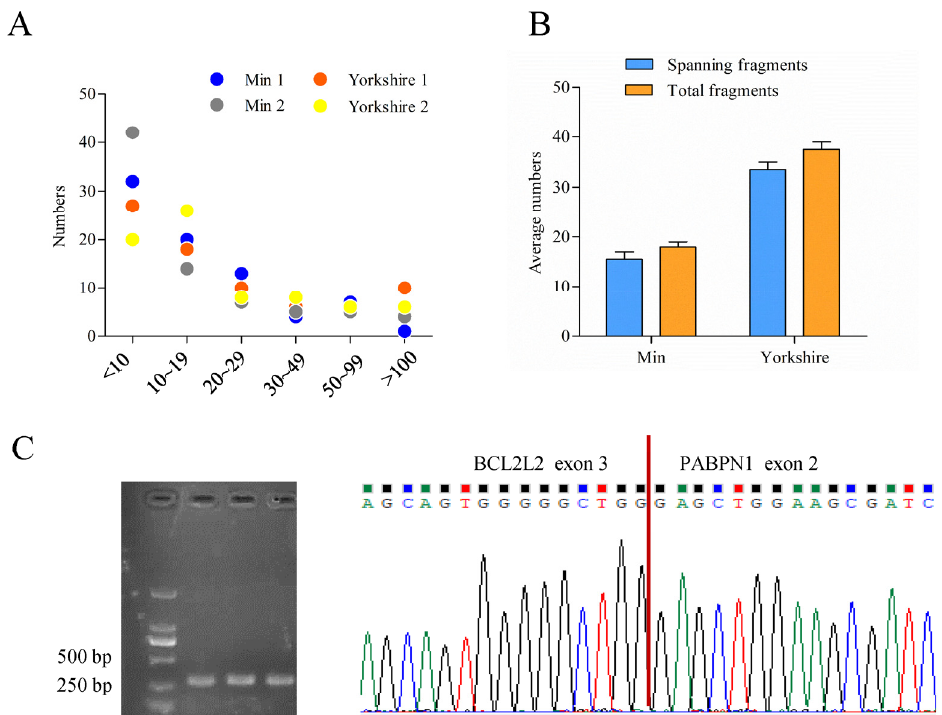
Figure 2. Characterization of porcine BCL2L2-PABPN1 (BP). ( A ) Score distribution of read-throughs identified. ( B ) Fragment distribution of BP in Min and Yorkshire pigs determined by ChimeraScan.